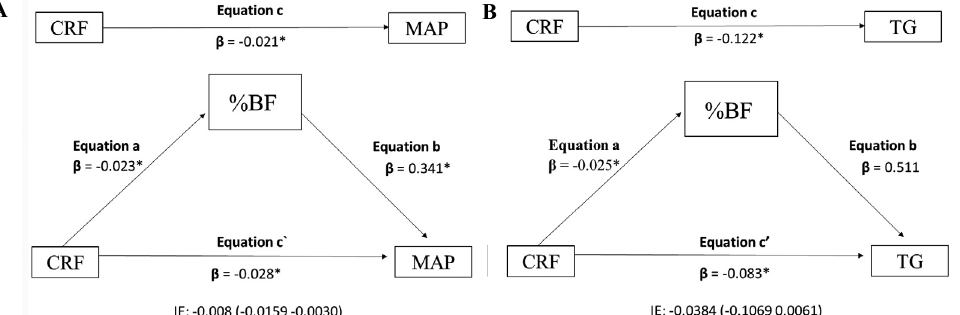
Figure 1. (A) Percentage of body fat mediation model of the relationship between cardiorespiratory fitness and mean arterial pressure; (B) Percentage of body fat mediation model of the relationship between cardiorespiratory fitness and triglycerides; CRF: Cardiorespiratory fitness; MAP: Mean arterial pressure; %BF: Percentage of body fat; TG: Triglycerides. *p<0.001. The analysis was adjusted for age, sex and